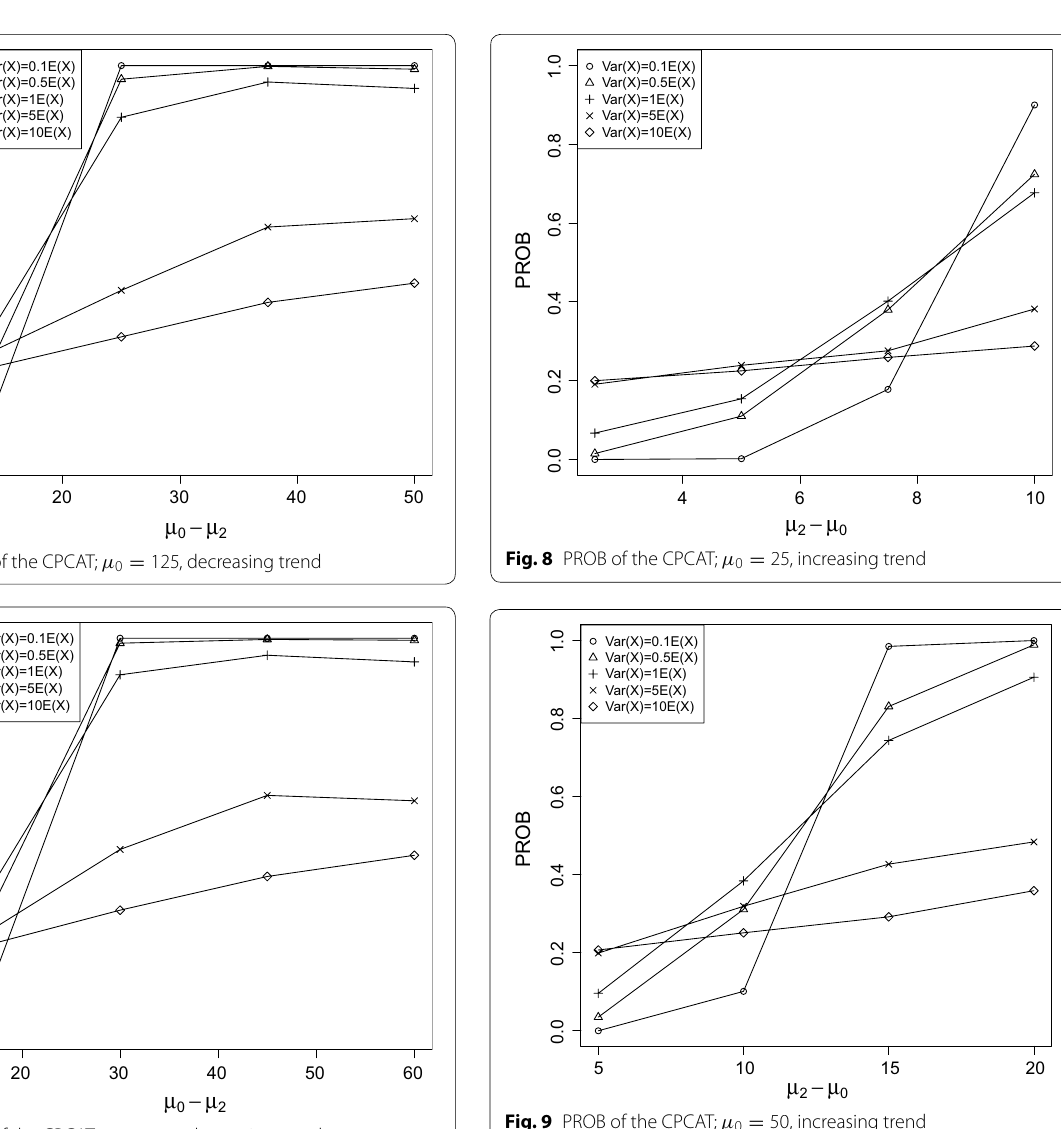
Fig. 7 PROB of the CPCAT; µ 0 = 150 , decreasing trend